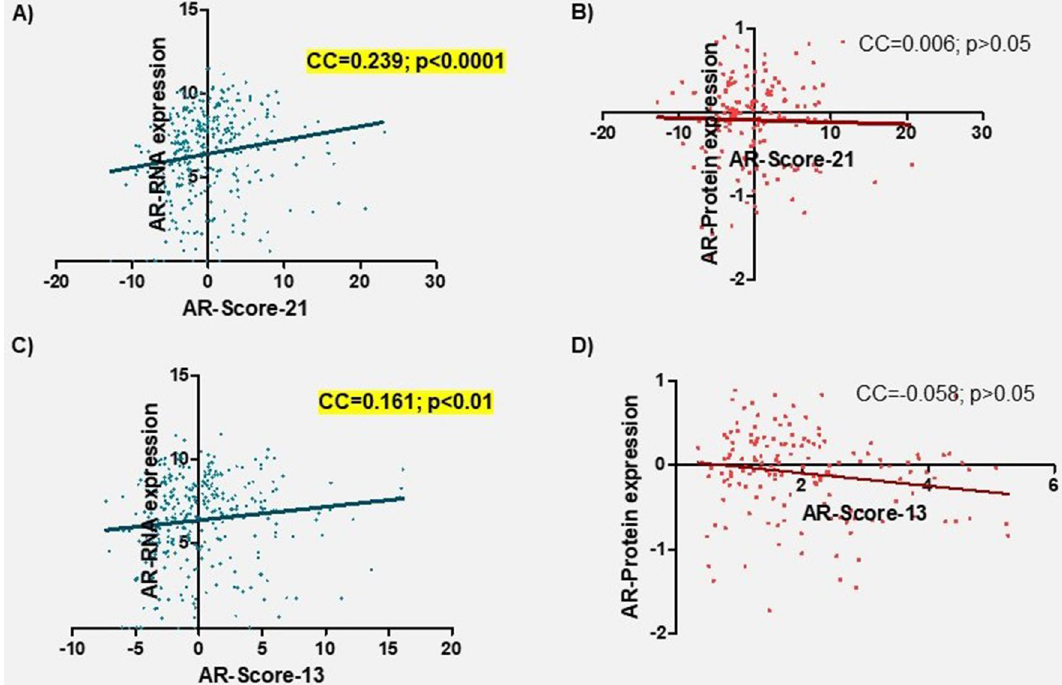
Figure 2. Correlation analysis between androgen receptor expression at RNA and protein levels and the AR-Score-21 ( A , B ) and AR-Score-13 ( C , D ). Spearman Rho test was used to calculate the correlation coefficients and p-values. All variables have been transformed using log2. CC correlation coefficient.